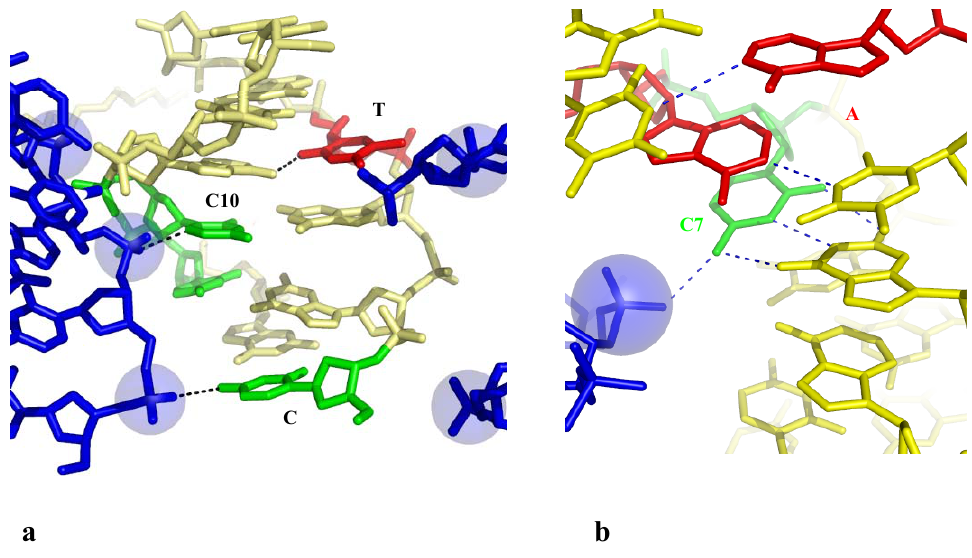
Figure 6. Indirect base pair opening induced by DNA-DNA interaction. ( a ) The hexamer d(CGGTGG) surrounded by two symmetry related molecules. The open base pairs are represented in red; ( b ) Detail of the groove-backbone interaction in the decamer